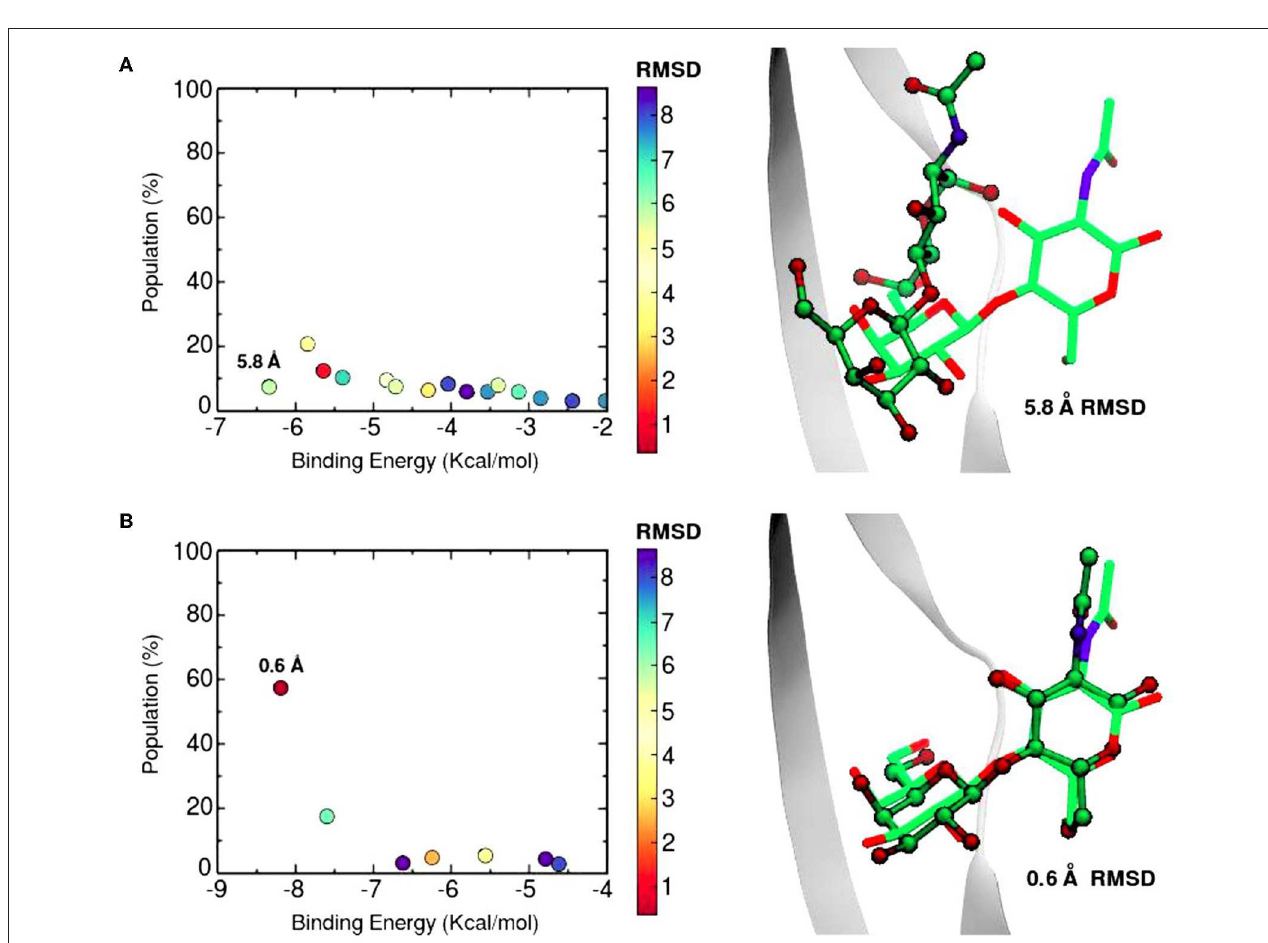
FIGURE 6 | Docking calculations of N-acetyl-lactosamine disaccharide to Gal-1 structure (PDB id: 1y1u). Results are presented as “Population vs. Binding Energy,” and a picture of the Best energy-ranked result for each docking method. (A) Conventional Autodock Docking Method. (B) Solvent-site Bias Docking Method (SSBDM). The values next to the dots represent the ligand heavy atom RMSD between the predicted ligand pose and the reference X-ray pose. The red dot indicates the location of the most accurate result.